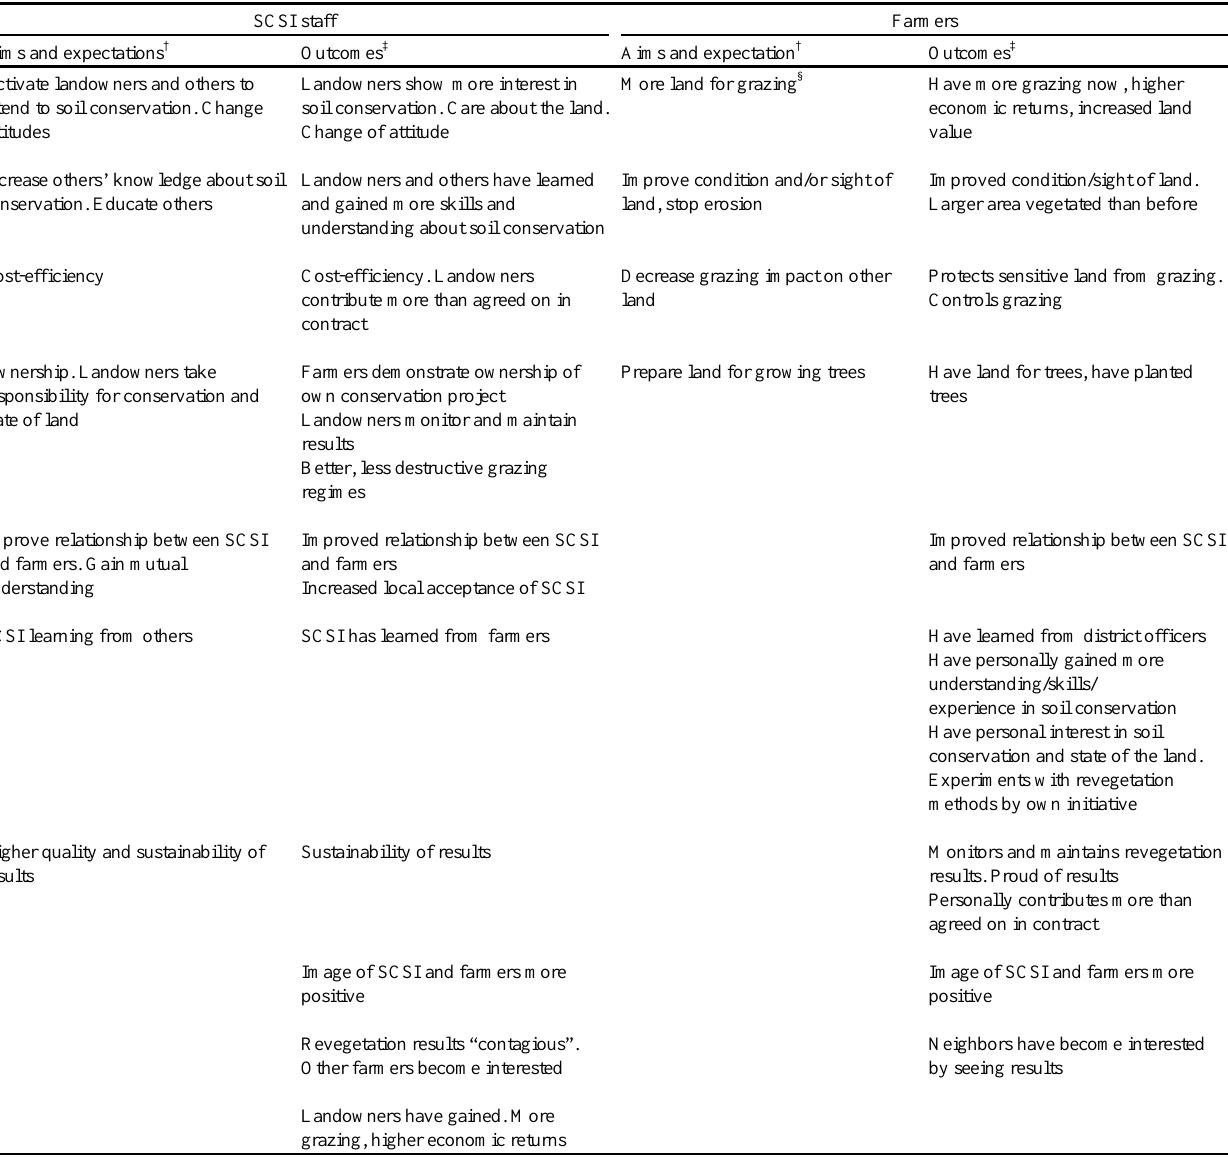
Table 4 . Aims, expectations, and outcomes of Farmers Heal the Land, mentioned by interviewed Soil Conservation Service of Iceland (SCSI) staff and participating